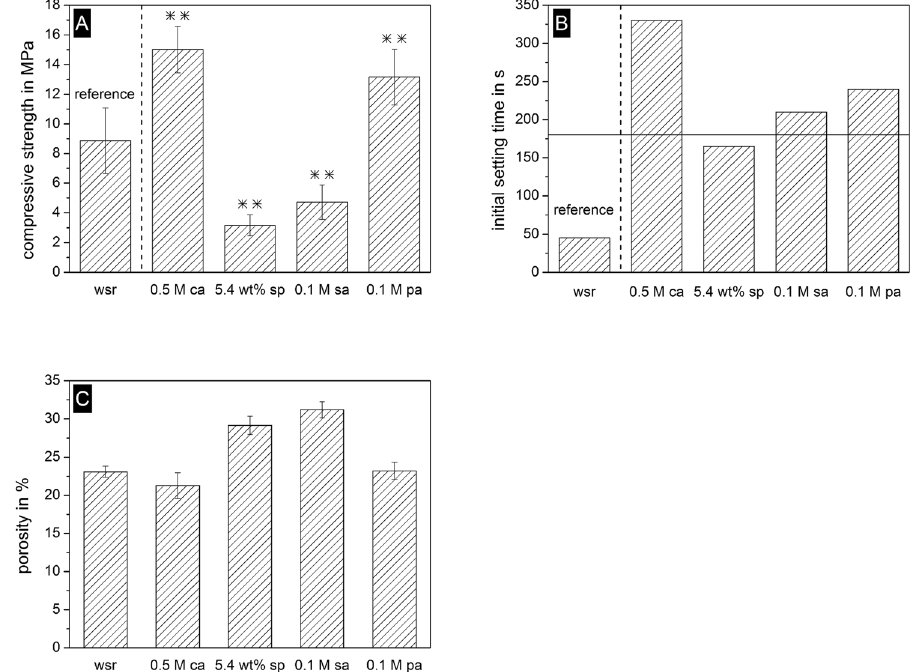
Figure 5. ( A ) Compressive strength of brushite with four different setting retardants. Cement without setting retardant served as reference. Samples marked with ** were highly significant (p < 0.001) with regard to the reference, ( B ) initial setting times according to Gillmore needle test (boundary for the initial setting time of 3 min is marked) and ( C ) porosity of set cements. Setting retardants citric acid (0.5 M ca), sodium pyrophosphate (5.4 wt% sp), sulfuric acid (0.1 M sa) and phytic acid (0.1 M pa) were compared to the reference without setting retardant (wsr).